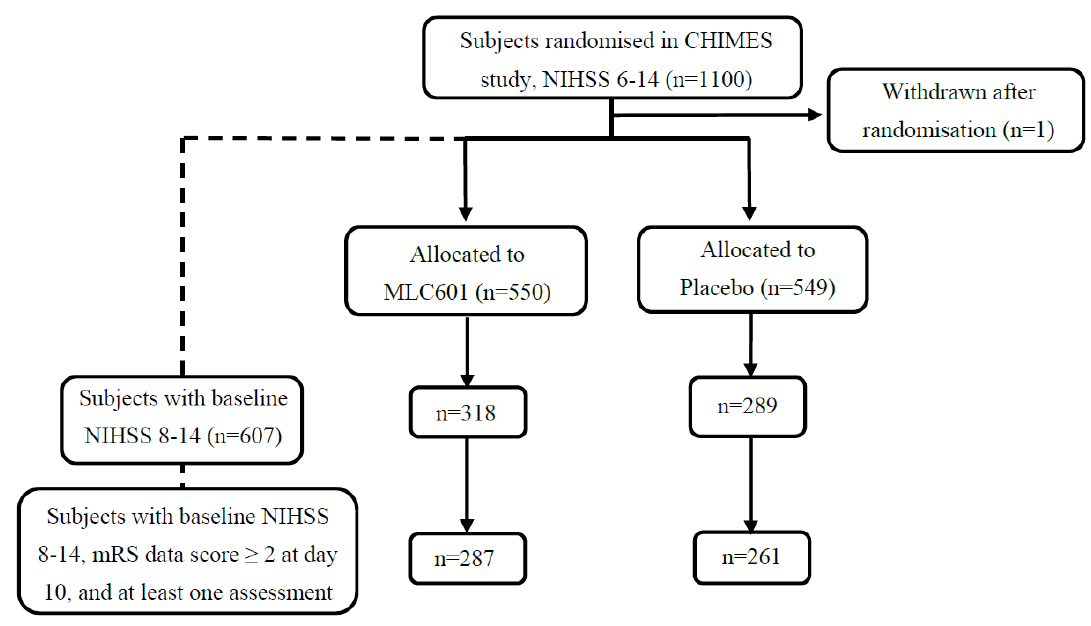
Figure 1. Flow chart of study population included in analysis of time savings. Table 1. Baseline characteristics in overall analysis population.